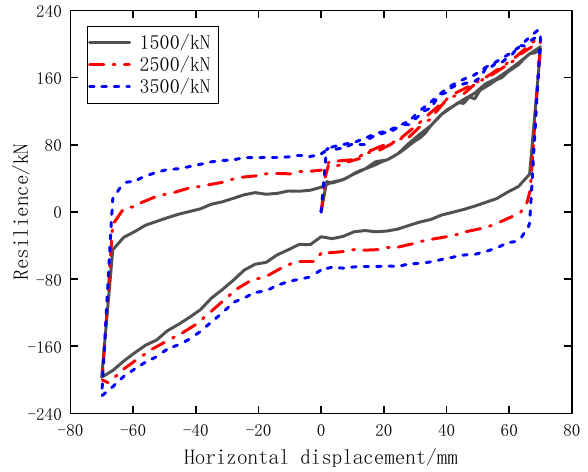
Figure 15. Hysteresis curves of SMA-negative stiffness hyperboloid shock absorber at different vertical pressures.